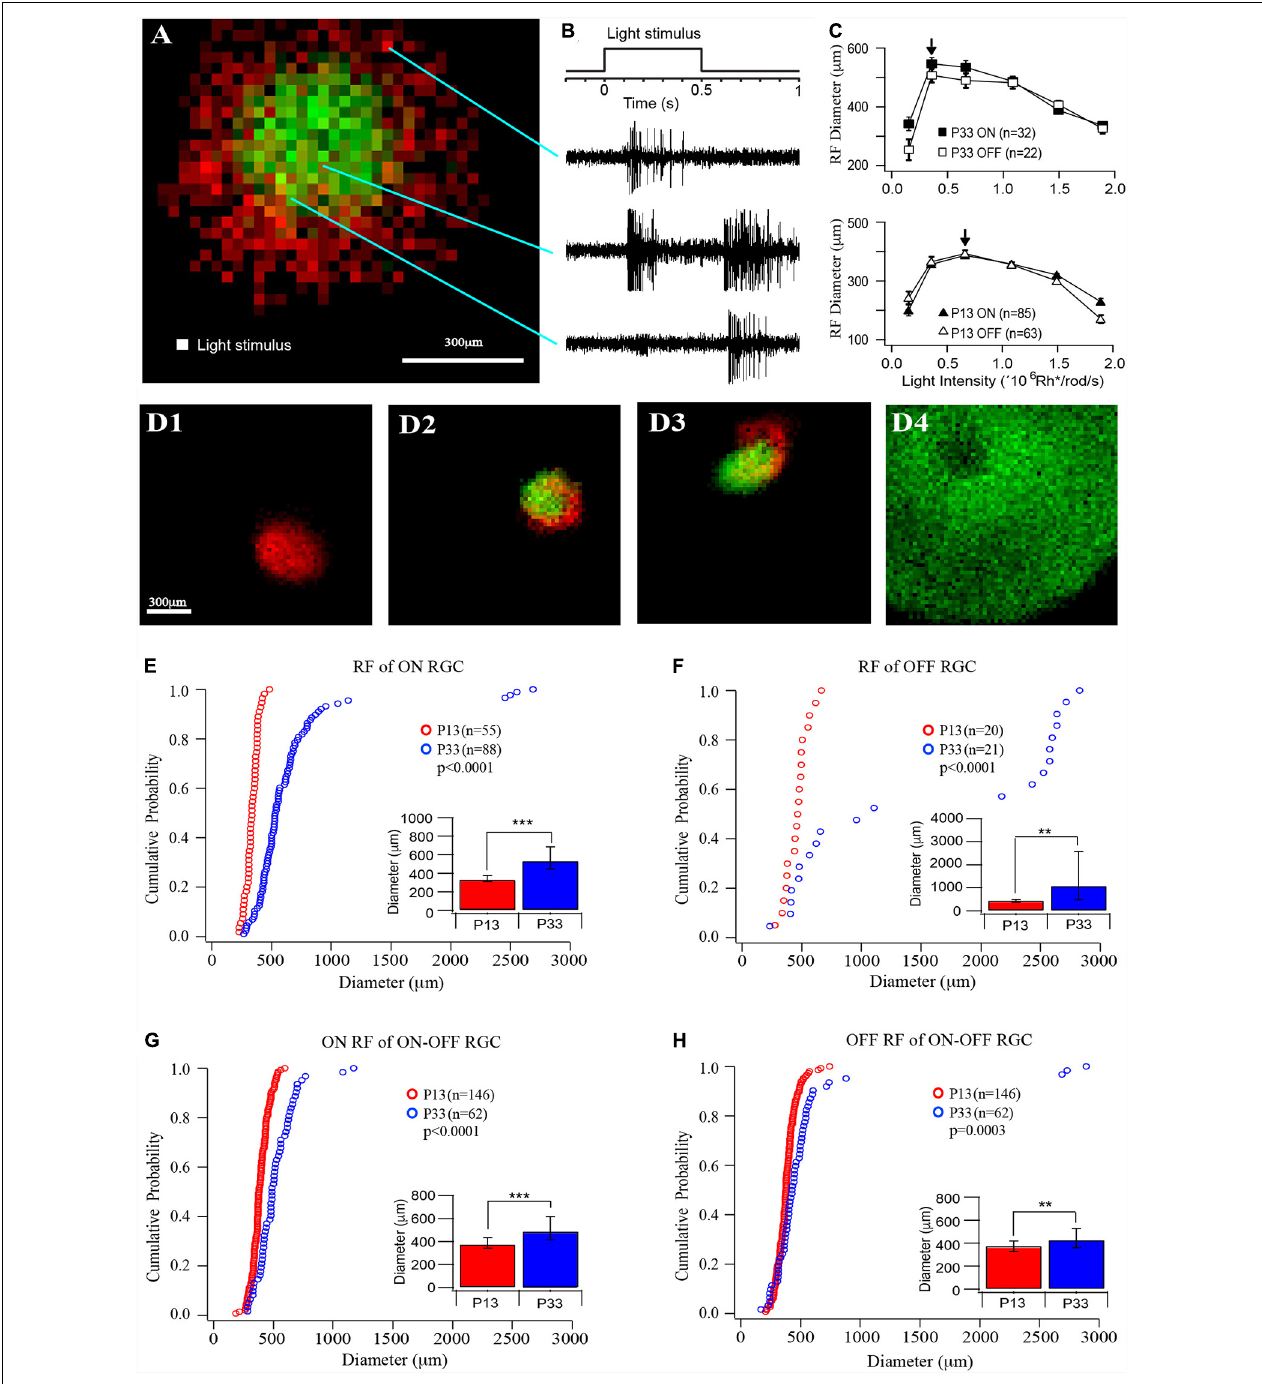
FIGURE 2 | The size of receptive fields of RGCs increases in the postnatal developing mouse retina. (A) Representative receptive field map of an ON–OFF RGCs. Red indicates the ON field, and green indicates the OFF field. The pixel size is 25 × 25 µ m. (B) Light stimulation and representative ON, ON–OFF, and OFF responses evoked by the stimulations at the locations indicated by the lines. (C) Plot of the average receptive field diameters versus light intensity for ON (open markers) and OFF (filled markers) fields of P33 (top, squares) and P13 (lower, triangles) mice. The arrows point to the peak diameter locations. (D) Four examples of receptive fields of an ON cell (D1), two ON-OFF cells (D2 and D3), and an OFF cell (D4). Red indicates ON receptive fields, and green indicates OFF receptive fields. ( D4) shows a representative picture of an OFF cell with a regular round but extremely large receptive field and a no-responding center. Because their receptive fields are generally bigger than the entire recording area (1.5 mm × 1.5 mm), we can only record part of the entire receptive field. ( E–H) Cumulative distribution curves of the diameter of receptive fields of ON, OFF, and ON–OFF RGCs from P12 (red) and P33 (blue) mice, respectively. Inset: median diameter of receptive fields. Error bars in the bar graphs indicate IQR. The p values were from K–S tests of cumulative distributions. The “*” sign is used to indicate p -value from Mood tests. **0.01 > p > 0.001; ***0.001 > p ; ns, not significant.